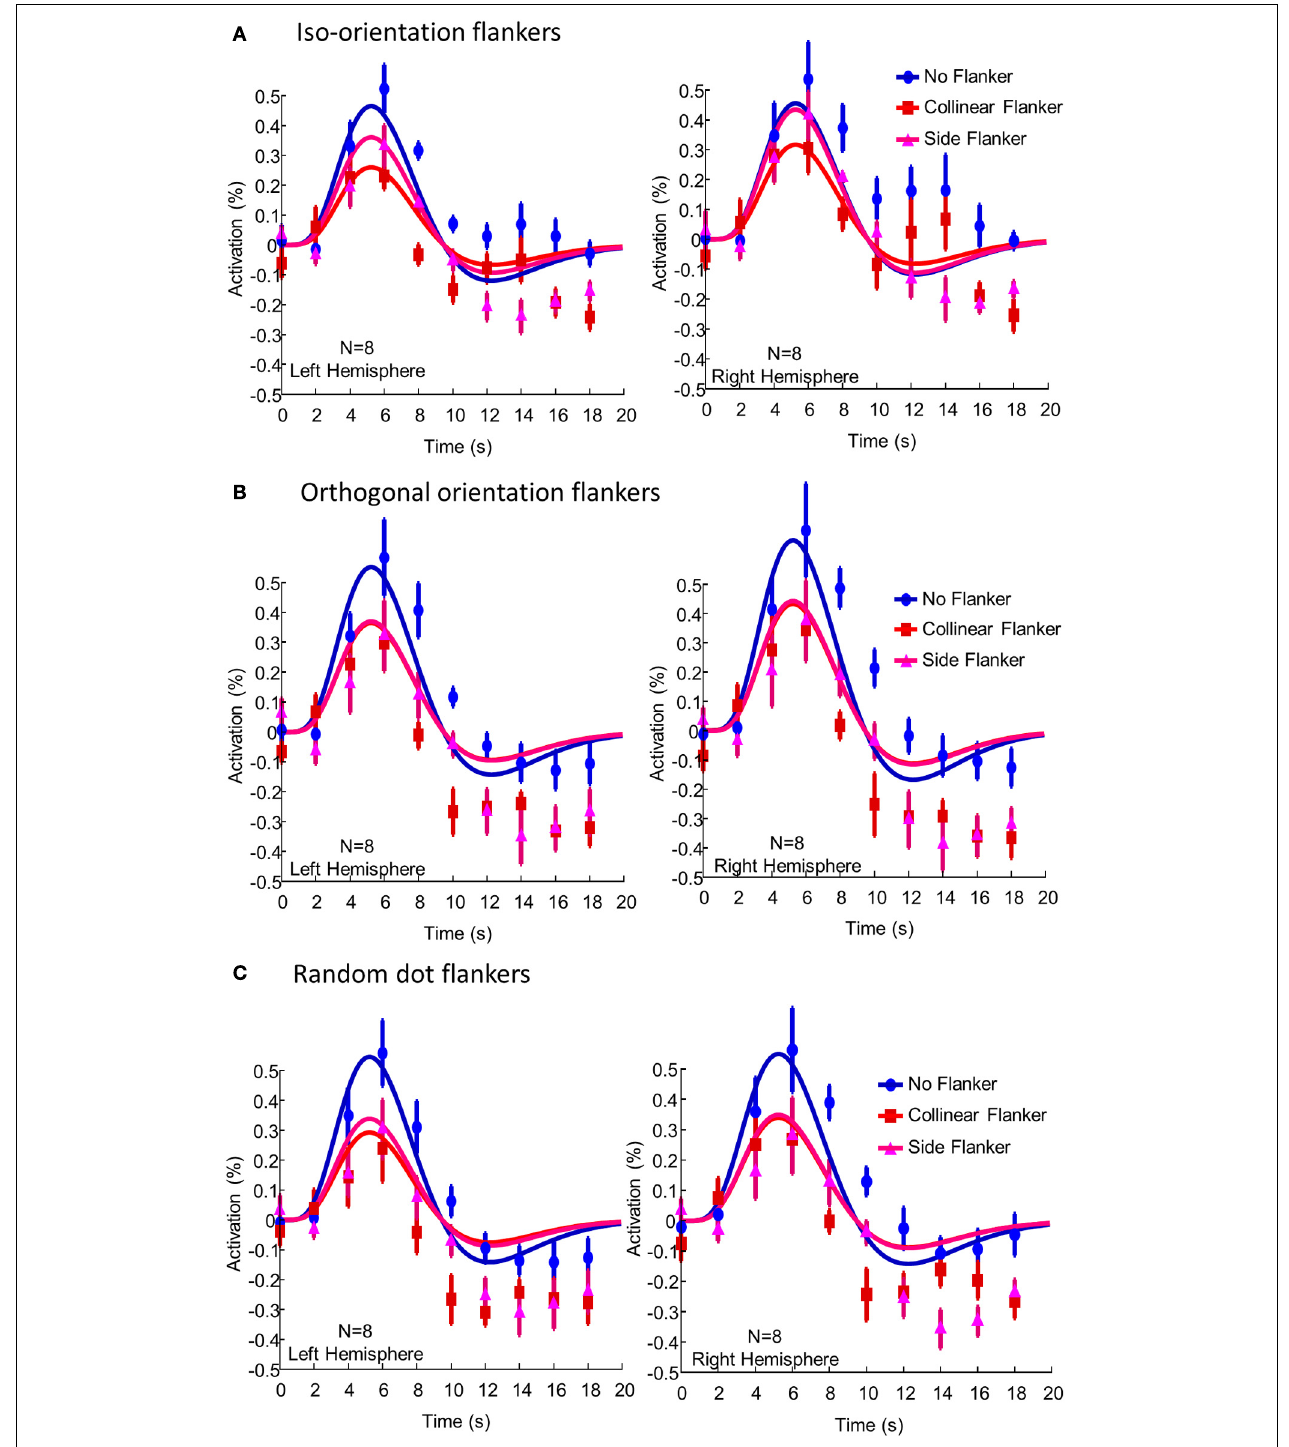
FIGURE 3 | The BOLD activation produced by the presence of the target in (A) the iso-orienation flanker condition, (B) the orthogonal flanker condition, and (C) the random dot flanker condition averaged across participants and voxels. The left and right columns show activations in the left and right hemisphere ROIs respectively. In each panel, blue symbols and